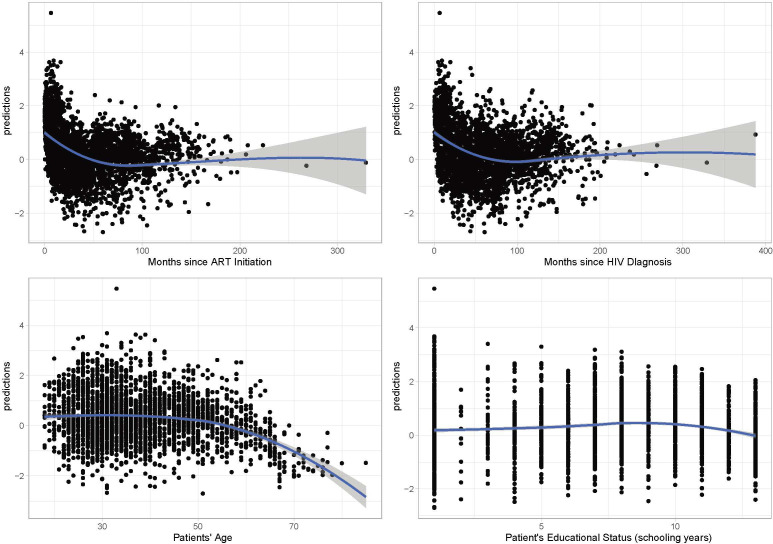
Heterogeneity plots for non-resting time use.